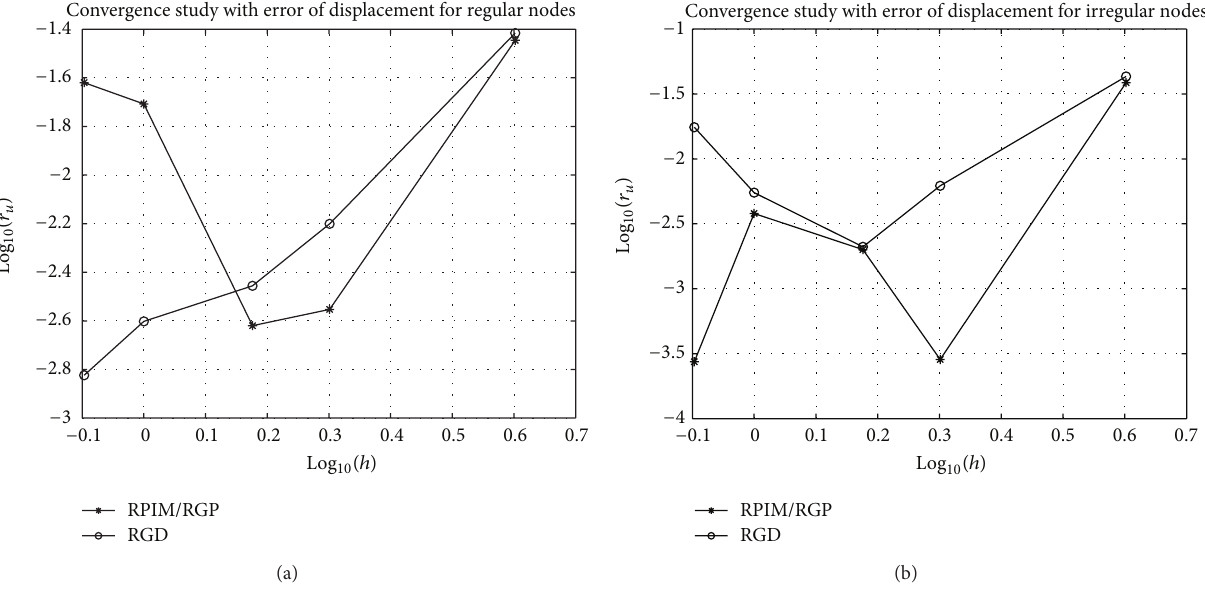
Figure 6: Convergence study with error of displacement: regular nodes (a), irregular nodes (b).